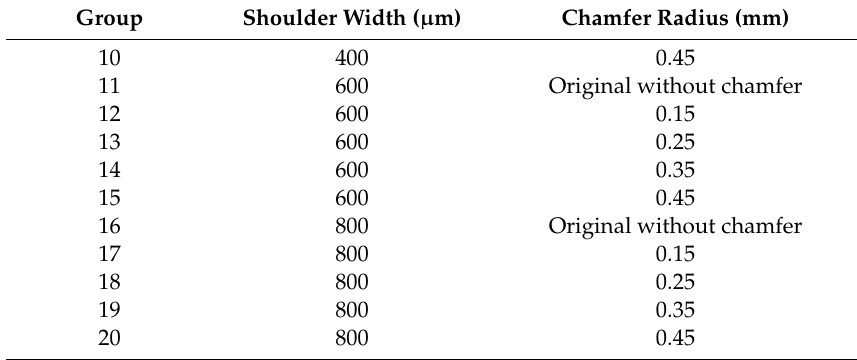
Figure 12. SEM images of the Cu sample ( a ) ×500 ( b ) ×1000 ( c ) ×1500 ( d ) ×3000.